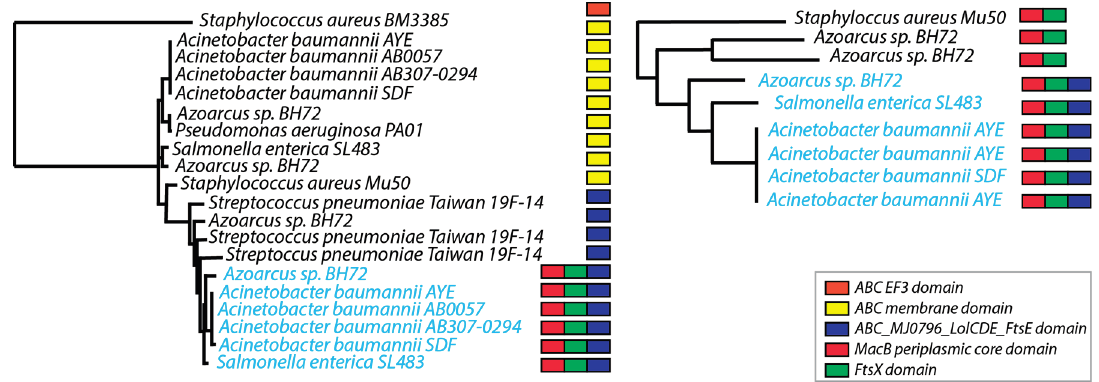
Figure 4. Maximum likelihood trees generated by Seaview. Both phylogenetic trees contain the six composite genes, indicated in blue font. The coloured squares indicate the domain architecture of the